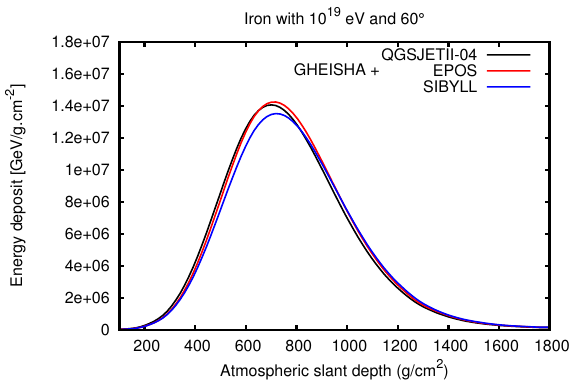
Figure 1. Number of charged particles given by QGSJETII- Figure 2. Energy deposit in air given by QGSJETII-04 alter- Figure 4. Energy deposit given by GHEISHA alternatively com- 04 alternatively combined with low energy hadronic interaction natively combined with low energy hadronic interaction mod- bined with high energy hadronic interaction models QGSJETII- models GHEISHA and UrQMD, for an incoming primary iron els GHEISHA and UrQMD, for an incoming primary iron with 04, EPOS and SIBYLL, for an incoming primary iron with E = 10 19 eV and θ = 60 ◦ . E = 10 19 eV and θ = 60 ◦ . with E = 10 19 eV and θ = 60 ◦ .